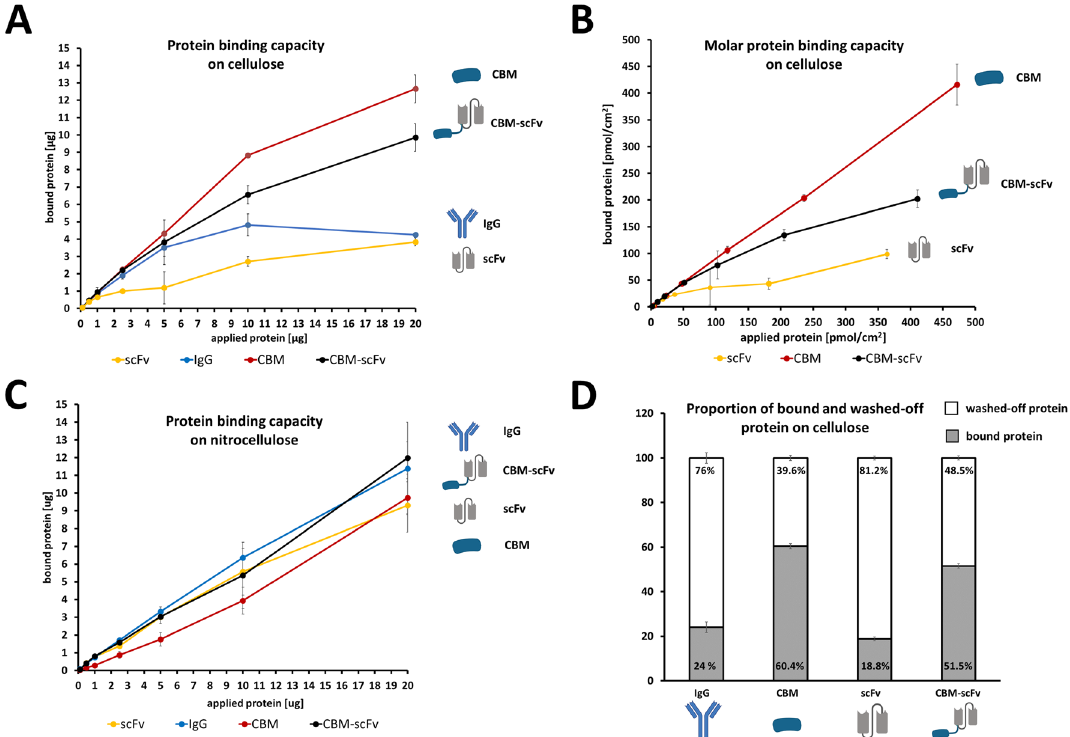
Figure 3. Cellulose and nitrocellulose protein-binding-studies using following proteins: CBM, scFv, CBM- scFv and IgG. ( A ) Protein binding capacity on cellulose paper. ( B ) Molar protein binding capacity on cellulose. ( C ) Protein binding capacity on nitrocellulose. ( D ) Proportions of bound and washed-off protein on cellulose. Experiments were performed according to Figure S6. Standard derivation was calculated using data derived from experimental